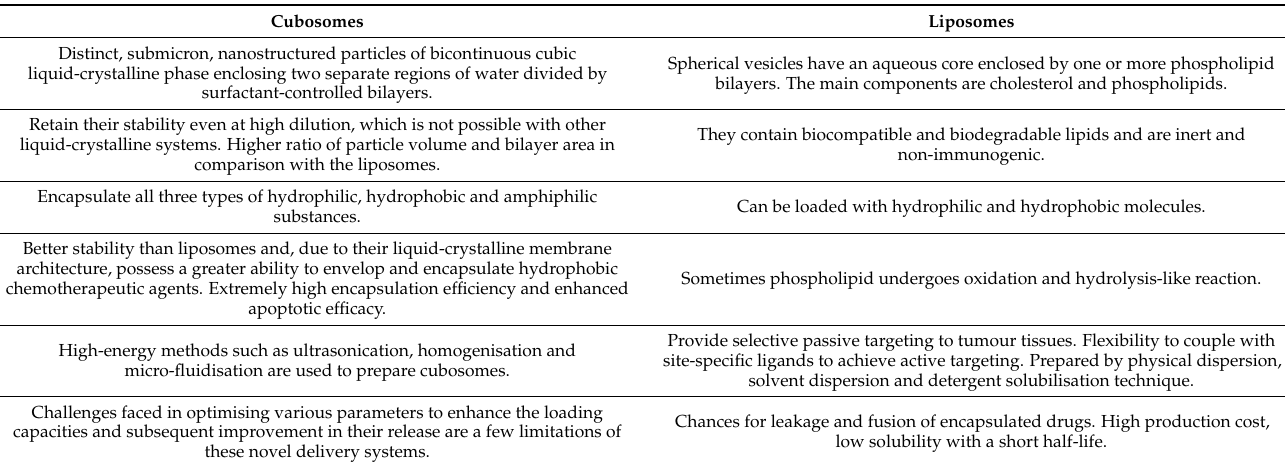
Table 1. Difference between cubosomes and liposomes